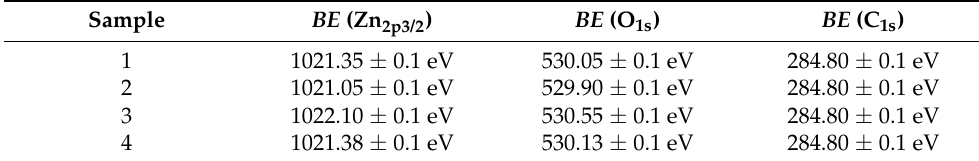
Table 1. Binding energies of Zn 2p3/2 , O 1s , and C 1s for all types of powder processing. Sample